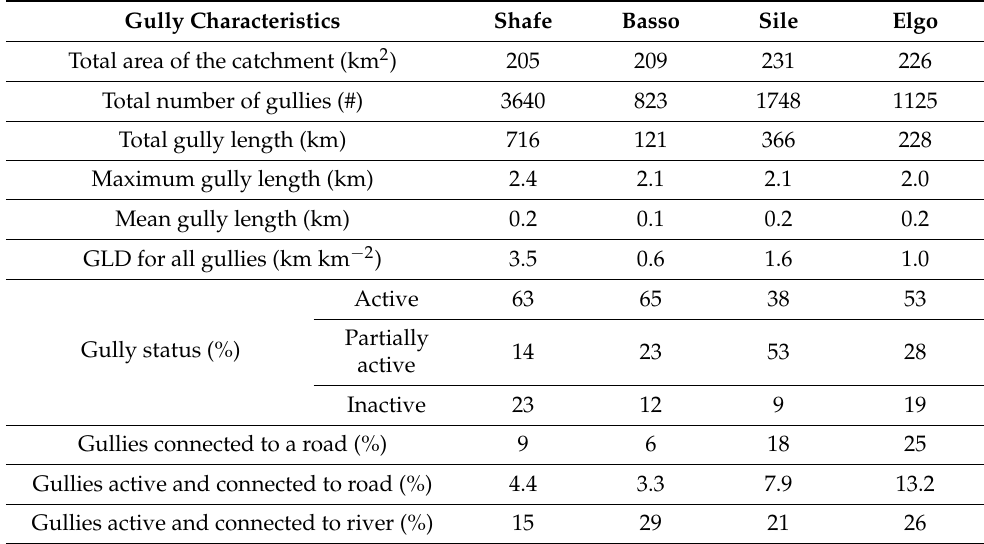
Table 1. Summary of the characteristics of gullies per river catchment. Gully Characteristics Shafe Basso Total area of the catchment (km 2